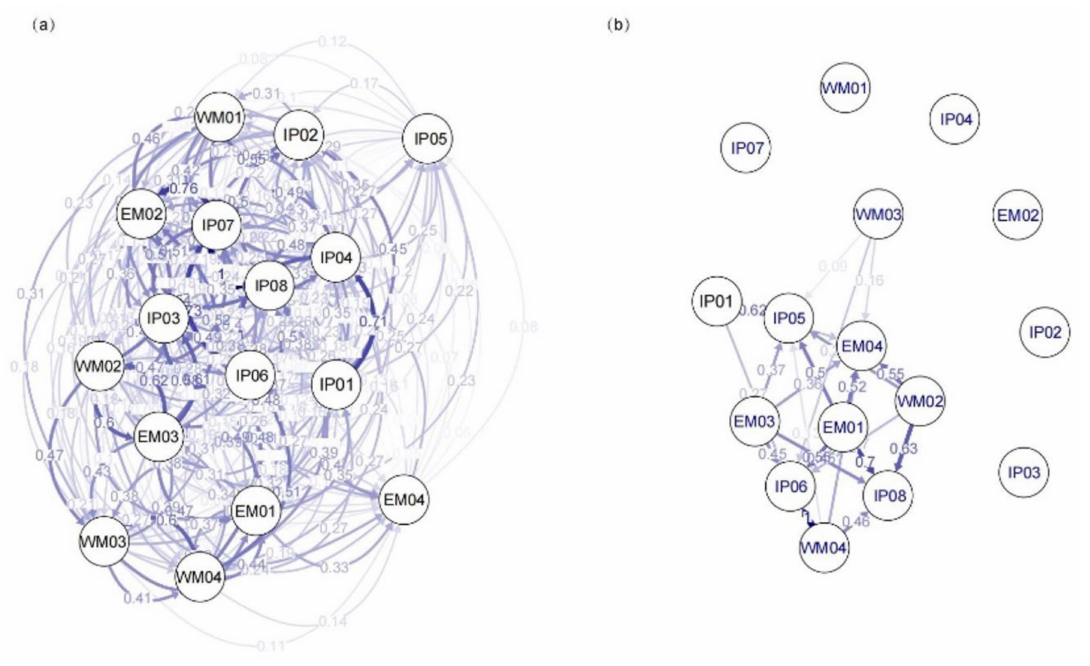
Figure 3. ( a ) The migration network among the 16 Hedyotis chrysotricha populations in the Thousand- Island Lake (TIL) region based on G ST (coefficient of gene differentiation) values and ( b ) significant relative migration relationships among populations (after 1000 bootstraps). Arrow thickness and color tone are proportional to the magnitude of the gene flow.